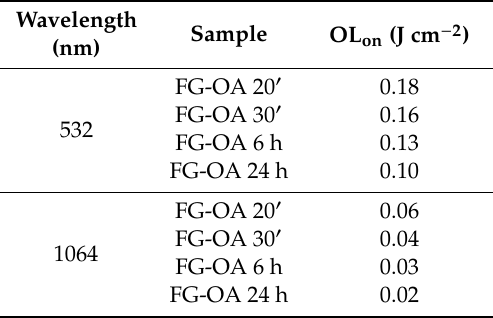
Table 3. Optical limiting onsets (OL on ) of FG-OAxs under 532nm and 1064 nm laser irradiation.